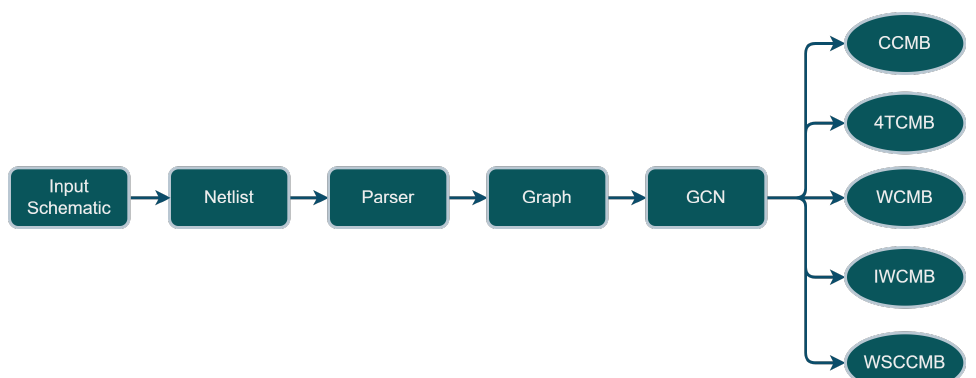
Figure 2. Overall system PIPELINE of the developed Analog Circuit Classifier. An input schematic is converted to a graph model through a parser we have developed. Then, the equivalent graph model is fed into the GCN to be classified into one of the following classes: Cascode Current Mirror Bank (CCMB), 4 Transistor Current Mirror Bank (4TCMB), Wilson Current Mirror Bank (WCMB), Improved Wilson Current Mirror Bank (IWCMB), Wide Swing Cascode Current Mirror Bank